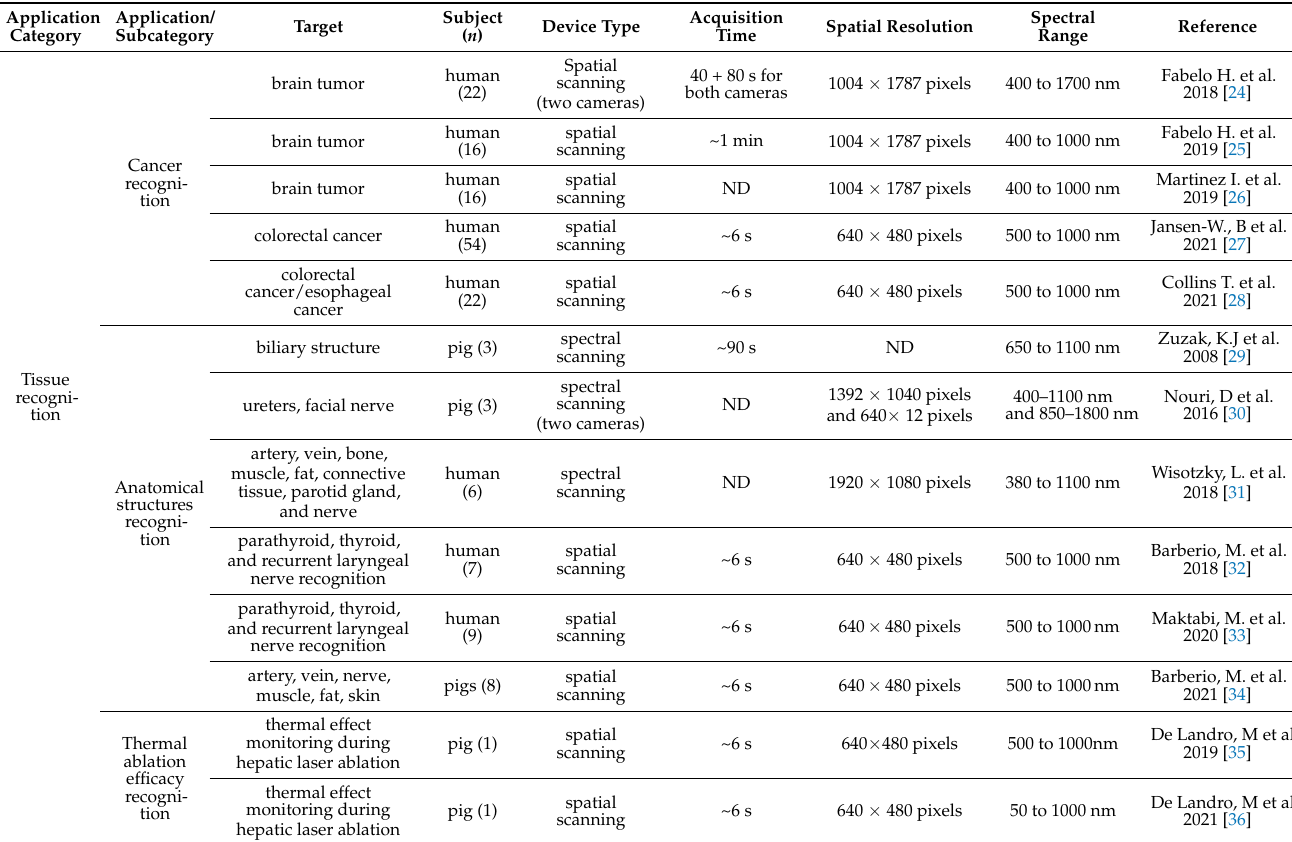
Table 1. Schematization of HSI applications split into surgical